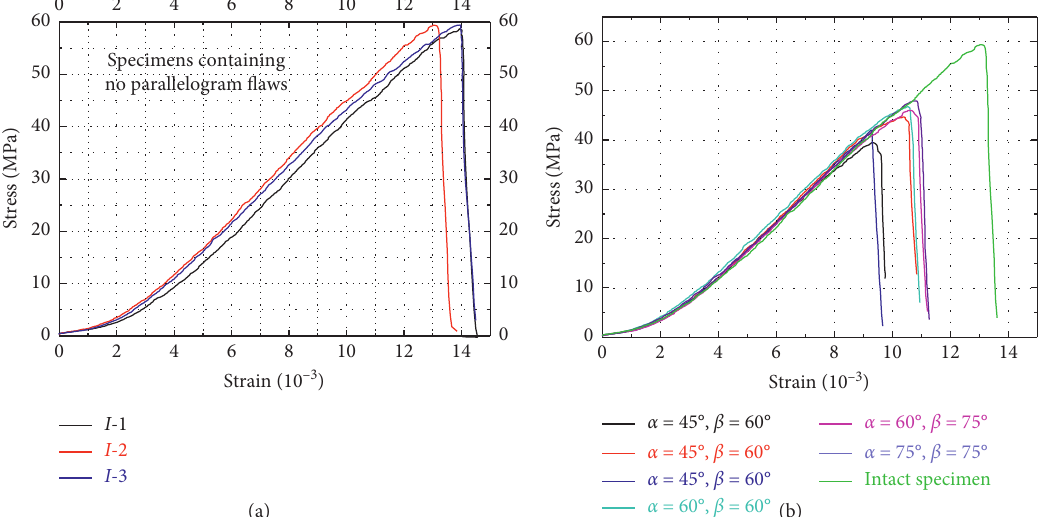
Figure 5: Stress-strain curves of specimens containing no parallelogram flaws (left) and two preexisting parallelogram flaws at different angles (right) under uniaxial